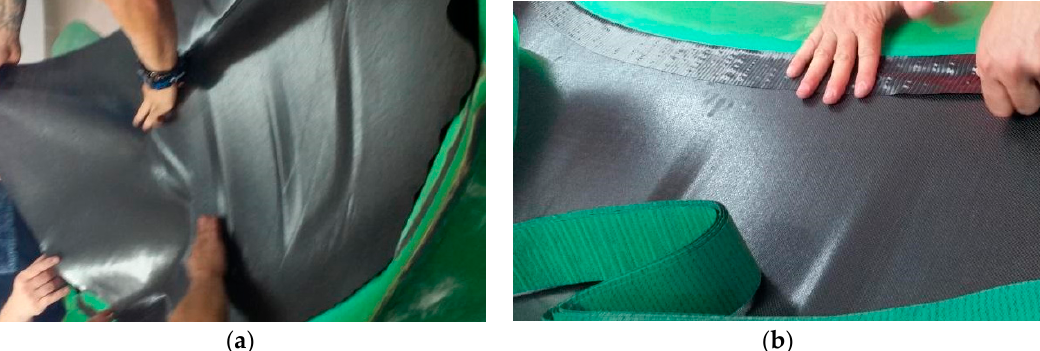
Figure 6. CFRP laminating process on hood mold: ( a ) laminating of CFRP surface layer; ( b ) laminating of reinforced borders with CFRP biaxial fabric.